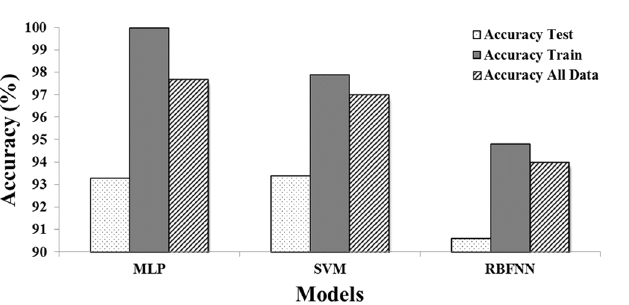
Figure 5. The confusion matrix of SVM neural network.